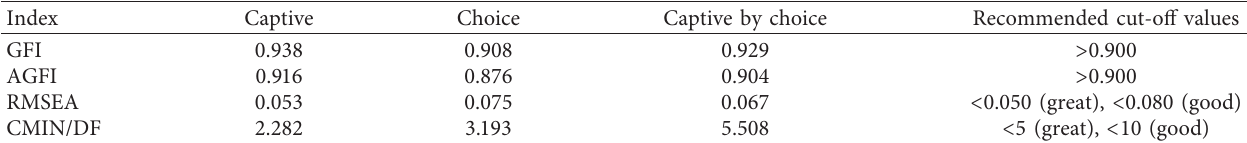
Table 8: Estimation index of comparison models and recommended cut-off